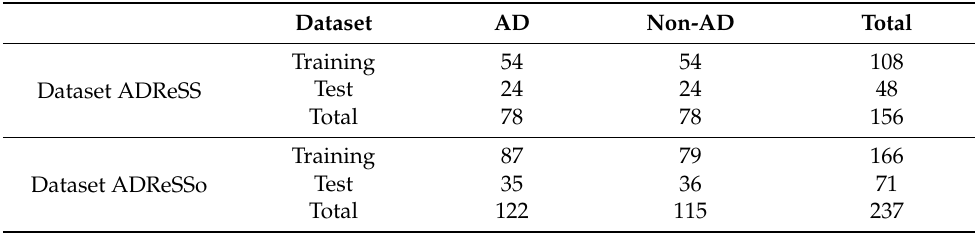
Table 1. Data composition of English public datasets. Dataset AD Non-AD Total Dataset ADReSS